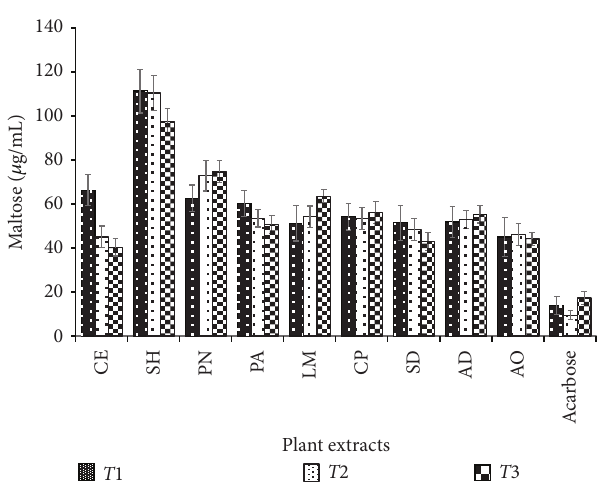
Figure 6: Maltose formation in the presence of selected antidi- abetic plants; CE, Chlorophora excelsa ; CP, Ceiba pentandra ; SH, Strophanthus hispidus ; SD, Synsepalum dulcificum ; PN, Picralima nitida ; AD, Anthocleista djalonensis ; PA, Persea americana ; AO, Anacardium occidentale; LM, Loranthus micranthus (1mg/mL). Results are expressed as mean ± SD ( 𝑛 = 4